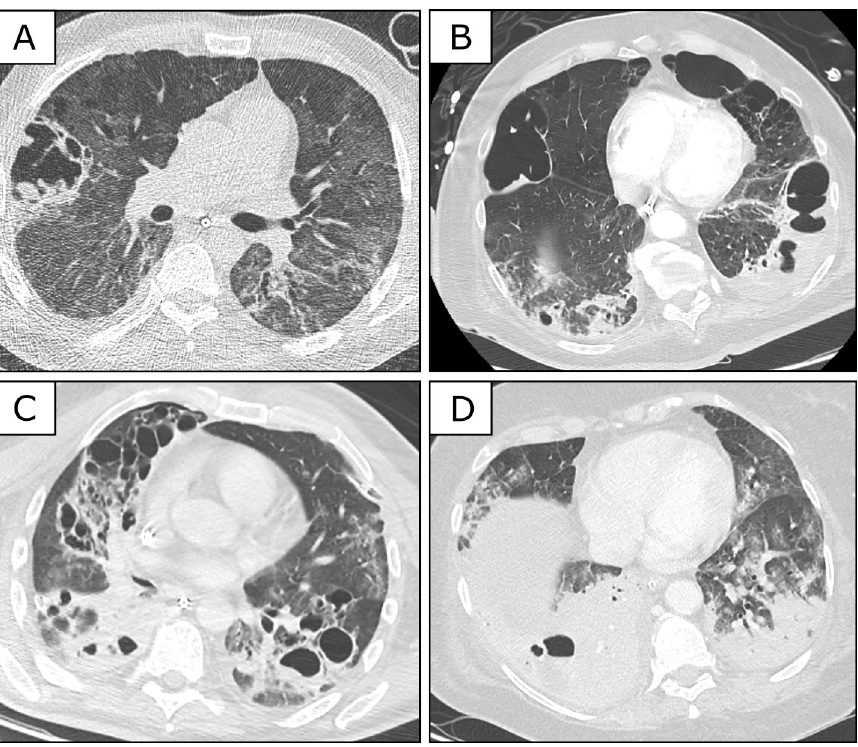
Figure 1. CT scans in COVID-19 patients receiving long term ICU care. CT scans showing typical cavitary lesions in four COVID-19 patients. ( A ) Single cavity in a 49-year old male patient 29 days after symptom onset; ( B ) bilateral cavitations in a 77-year old male patient 39 days after onset of symptoms; ( C ) extensive bilateral cavities in a 57-year old male patient on day 36 after symptom onset; ( D ) right-sided cavitation in a large lower lobe consolidation in a 69-year old female patient 29 days after onset of symptoms. Only open source software (GIMP 2.10.18 https:// www. gimp. org/ and Inkscape, Version 1.0 (4035a4fb49, 2020–05-01) ) were used to generate the